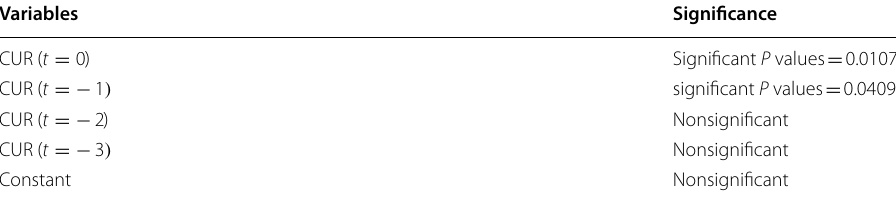
Table 3 First-step model 1 estimation. Source : Calculated by the author using EViews